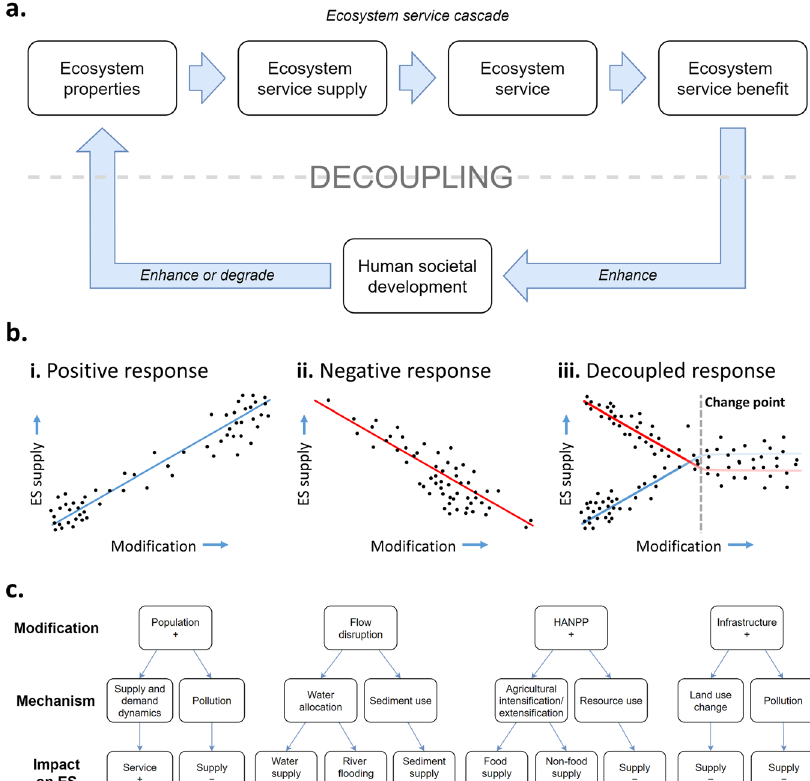
Fig. 1 Graphical representations of decoupling and its mechanisms. a Decoupling of the ecosystem service cascade. The traditional ecosystem service cascade fl ows from ecosystem property or function to bene fi t 12 ; these ecosystem services (ES) can maintain and promote human societal development which can then enhance or degrade the ecosystem properties on which ES are based. Decoupling disconnects societal development from this cascade, as local ES are replaced with external inputs. b Characteristic response curves of ES to the modi fi cation of natural systems by societal development. i. Positive response of ES to modi fi cation in a coupled system. ii. Negative response of ES to modi fi cation in a coupled system. iii. Weakening of responses (or feedbacks) between modi fi cation and ES beyond a change point in a decoupled system. c Mechanisms through which the modi fi cation of river deltas can impact local ES. The mechanisms and impacts on ES of an increase in population, the disruption of water fl ow through dams and reservoirs, human appropriation of net primary productivity (HANPP), and built infrastructure. Impacts can affect both supply, the potential ES available from nature; and service, the realised ES used by people. Positive and negative signs indicate, respectively, an increase or decrease in the